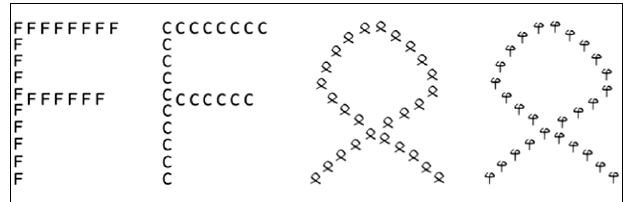
FIGURE 4 | Illustration of the hierarchical stimuli presented in a study by Lachmann etal. (2014) using the Navon paradigm (Kinchla, 1974; Navon, 1977). Left side: examples for letters, right side: examples for non-letters. First stimulus example: the local and the global level consists of the same letter F (congruent letter stimulus). Second stimulus example: the global-level letter (F) differs from the local level one (C).Third stimulus example: congruent non-letter stimulus; fourth stimulus example: incongruent non-letter